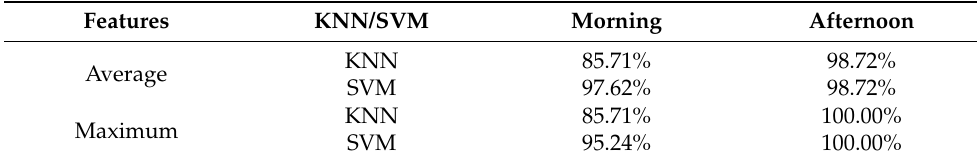
Table 7. The accuracy for odor classification in different sampling locations of chicken house at the same sampling time.